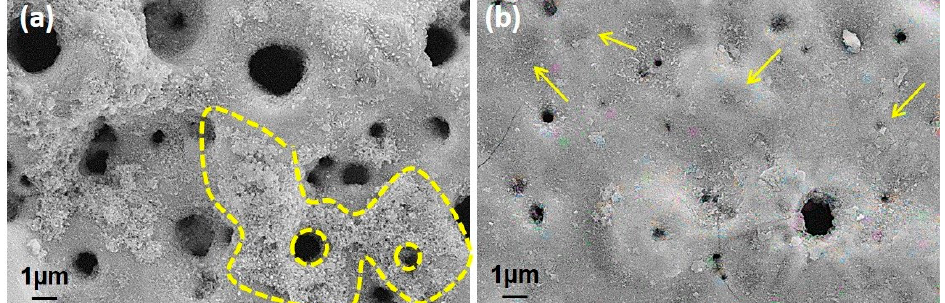
Figure 10. ( a ) The heavy corrosion tracks at the surroundings of pores in 1.0 wt% doped GNS coating and ( b ) closed pores due to the existence of GNS in the 1.5 wt% GNS coating. and ( b ) closed pores due to the existence of GNS in the 1.5 wt% GNS coating.